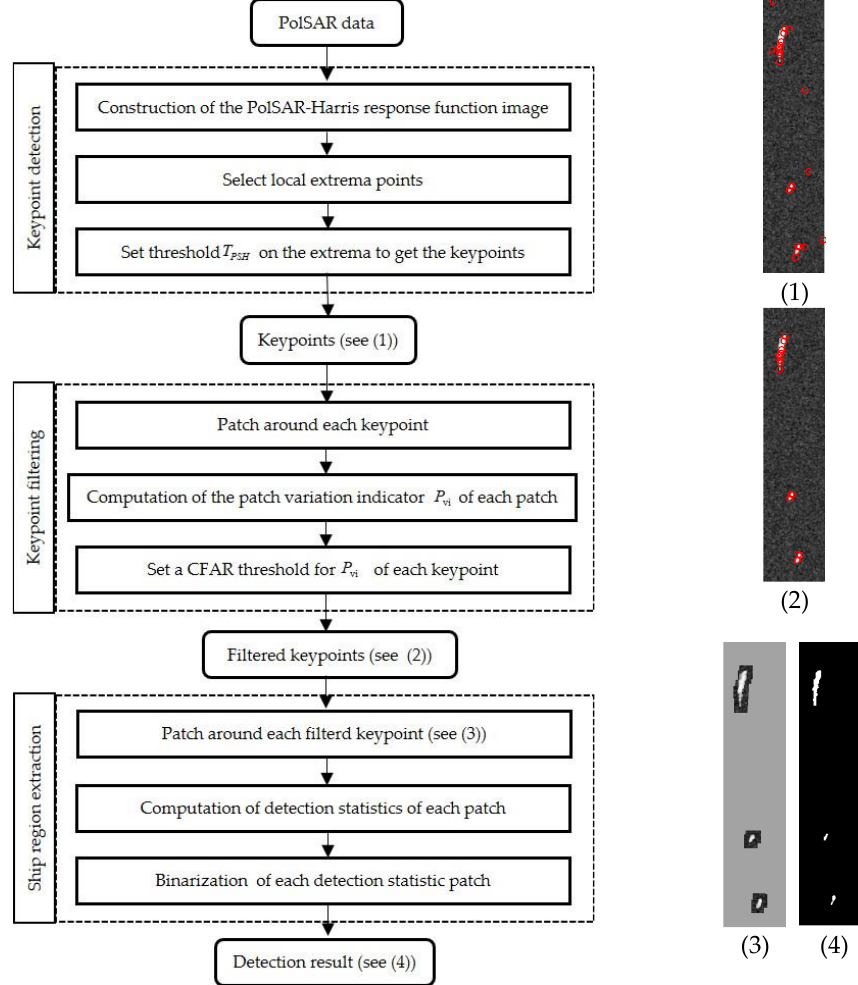
Figure 1. Outline of the PolSAR-SIFT ship detection algorithm, which includes three steps: (1) key- point detection (PolSAR-Harris); (2) keypoint filtering; and (3) ship region extraction. The background in (1) and (2) is the log SPAN image.